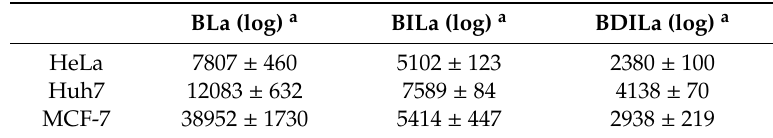
Table 3. Corrected median fluorescence intensities (MFI) of the dyes BLa, BILa and BDILa against treated cancer cell lines.